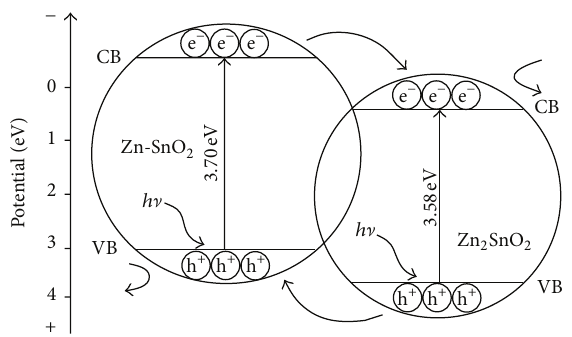
Figure 7: Schematic diagram for the illustration of the energy band structure and photogenerated electron hole pair separation in the Zn-doped SnO 2 /Zn 2 SnO 4 nanocomposites [10,